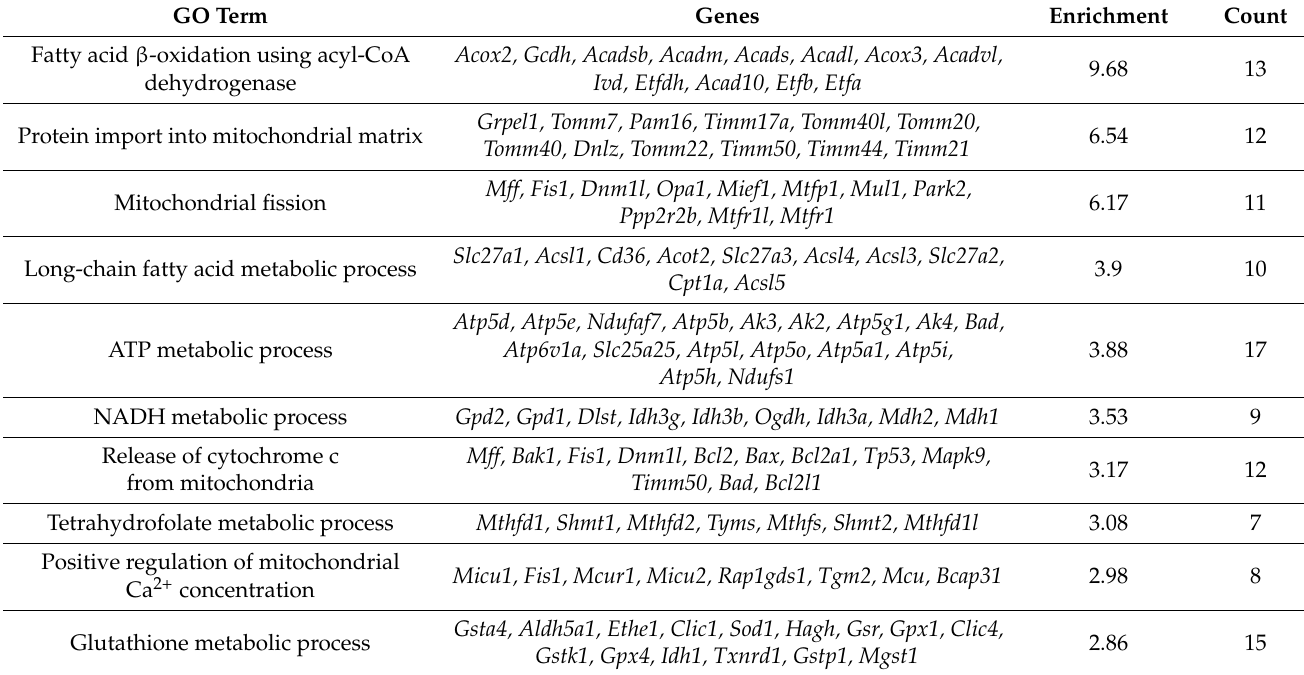
Table 2. Biological processes (GO Terms) connected with “mitochondrial metabolism” that were significantly changed in the rat liver. Several processes were considered as significantly changed (FDR ≤ 0.05) according to the analysis of mitochondrial genes during the perinatal period—16th foetal day to the 4th postnatal day. No such biological process was identified in skeletal